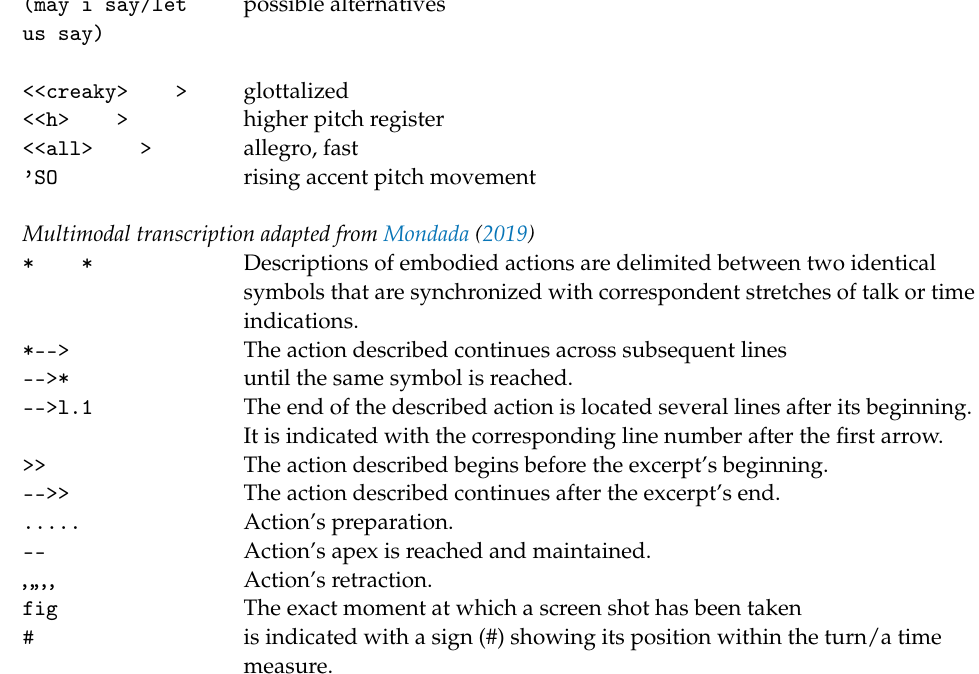
The exact moment at which a screen shot has been